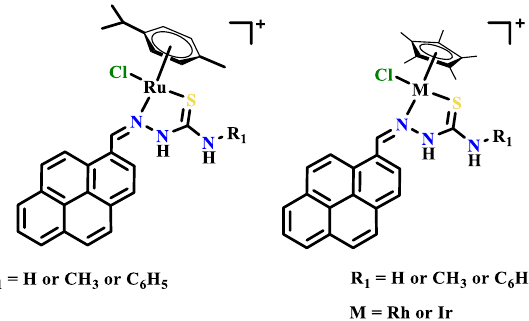
Figure 51. Organo-Ru(III)/Rh(III)/Ir(III) complexes of pyrene hydrazone with ( N -methyl/phenyl)- substituted thiourea as the side chain.